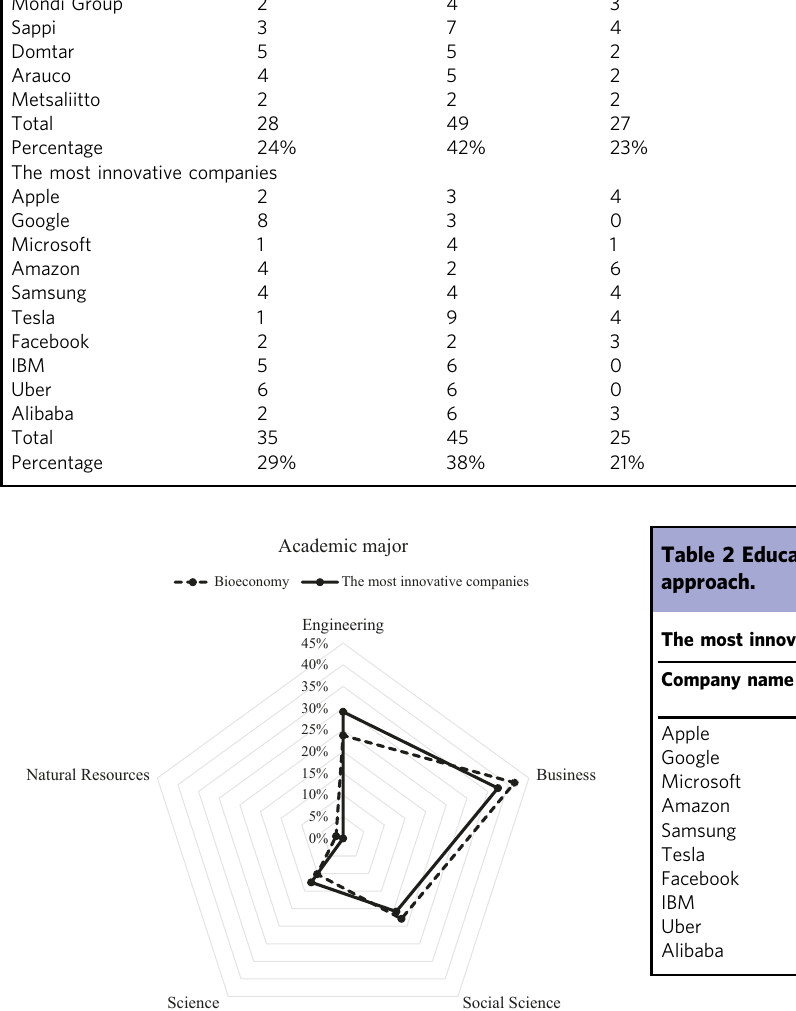
Fig. 1 Radar chart of types of education for board of directors in both company groups. Educational disciplines for bioeconomy companies (dotted line) and the most innovative companies (solid line).